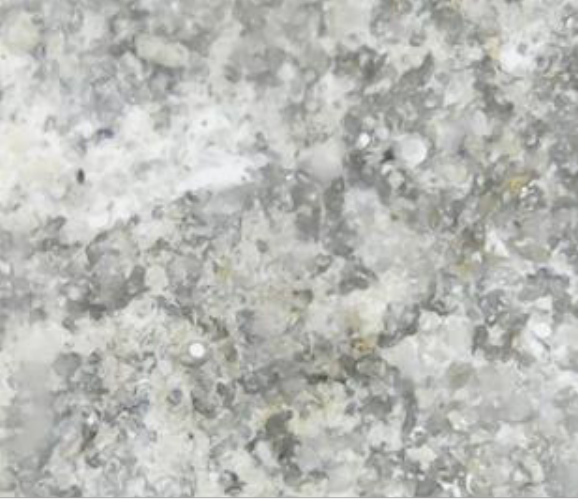
Figure 6. S3 sample series; magnification 500 X.